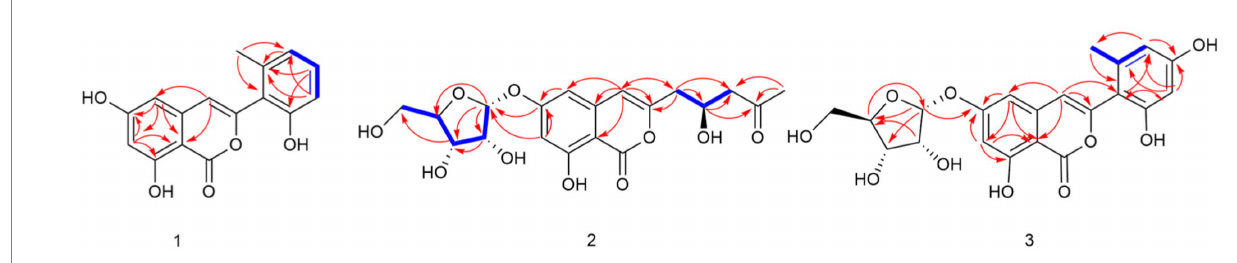
FIGURE 2 Key COSY (bold lines) and HMBC (arrows) correlations of compounds 1 – 3 .